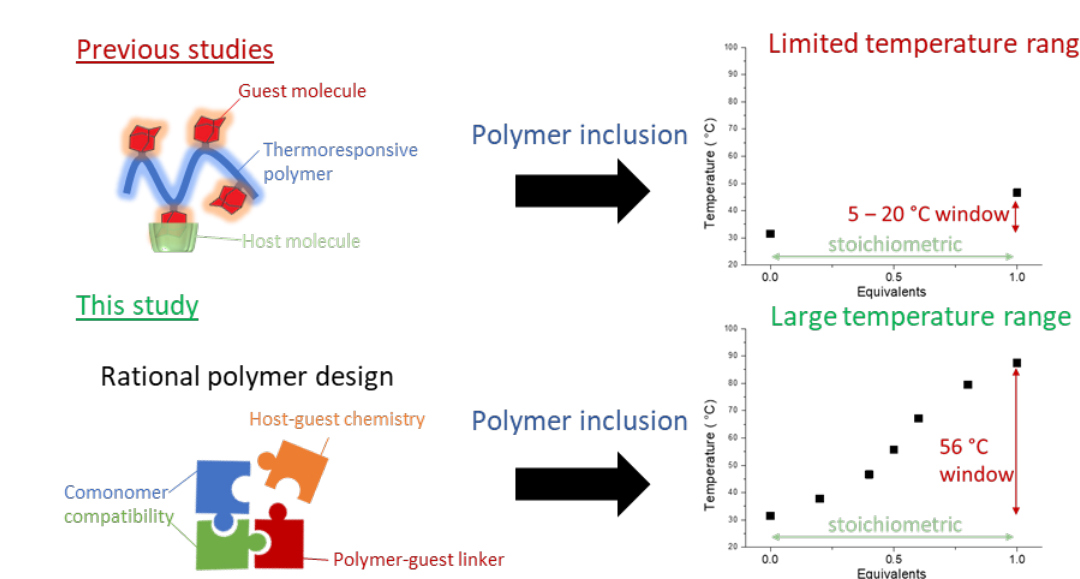
Figure 1. Schematic illustration on the application of rational polymer design through post-polymerization modification in combination with host–guest chemistry (polymer inclusion), presented in this work toward the development of widely tunable lower critical solution temperature (LCST) behavior.